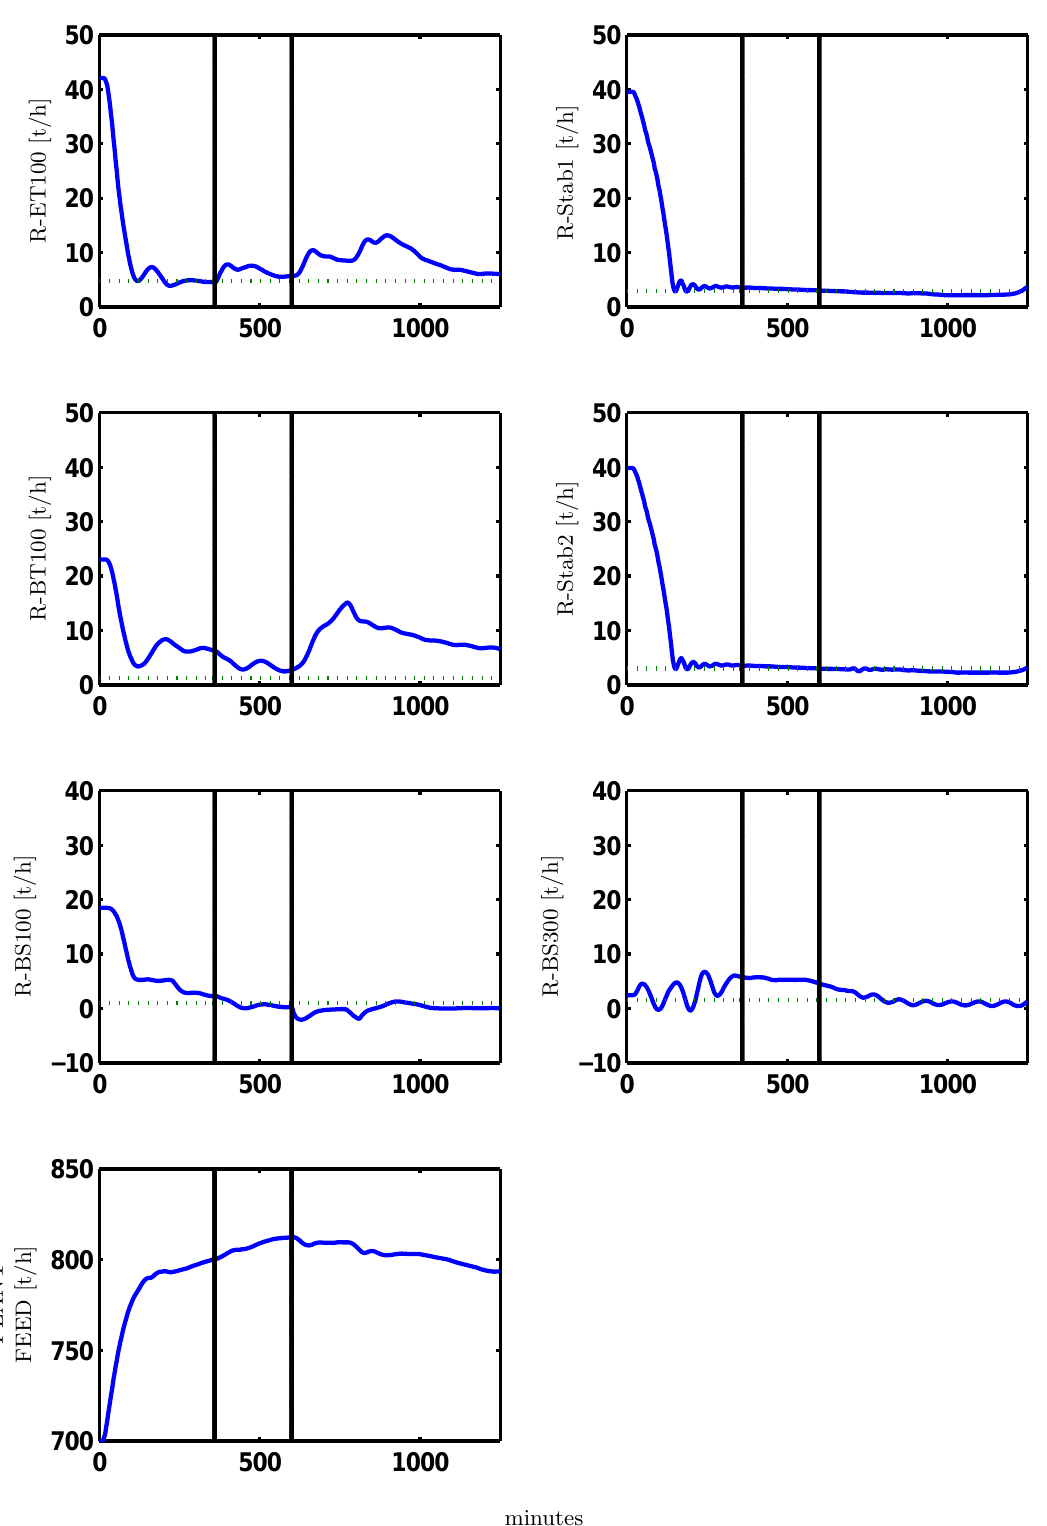
Figure 4: The most important CVs in the coordinator MPC (solid) with CV limits (dotted)